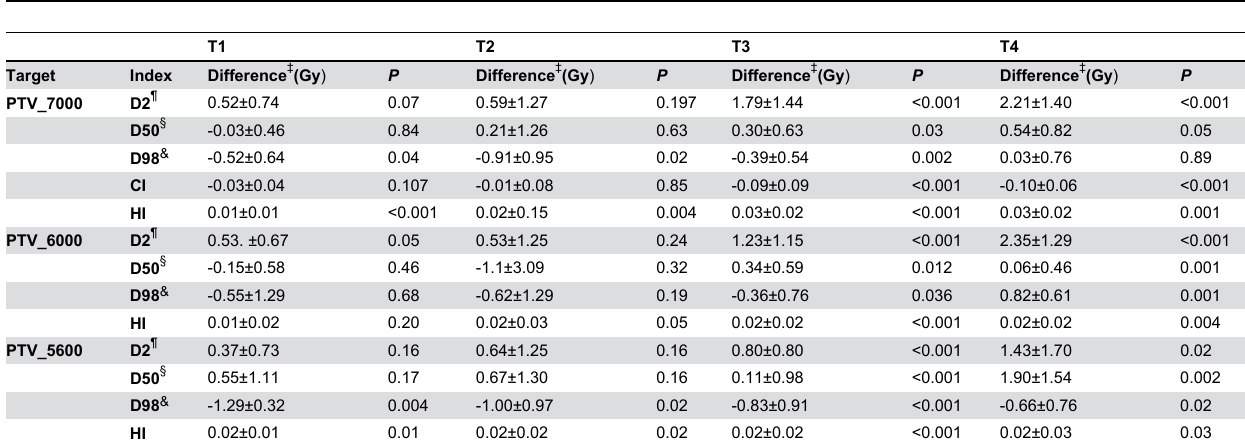
Table 3. Mean difference in dose between s-IMRT and VMAT of s-IMRT and VMAT for the PTVs in 52 NPC patients stratified by T